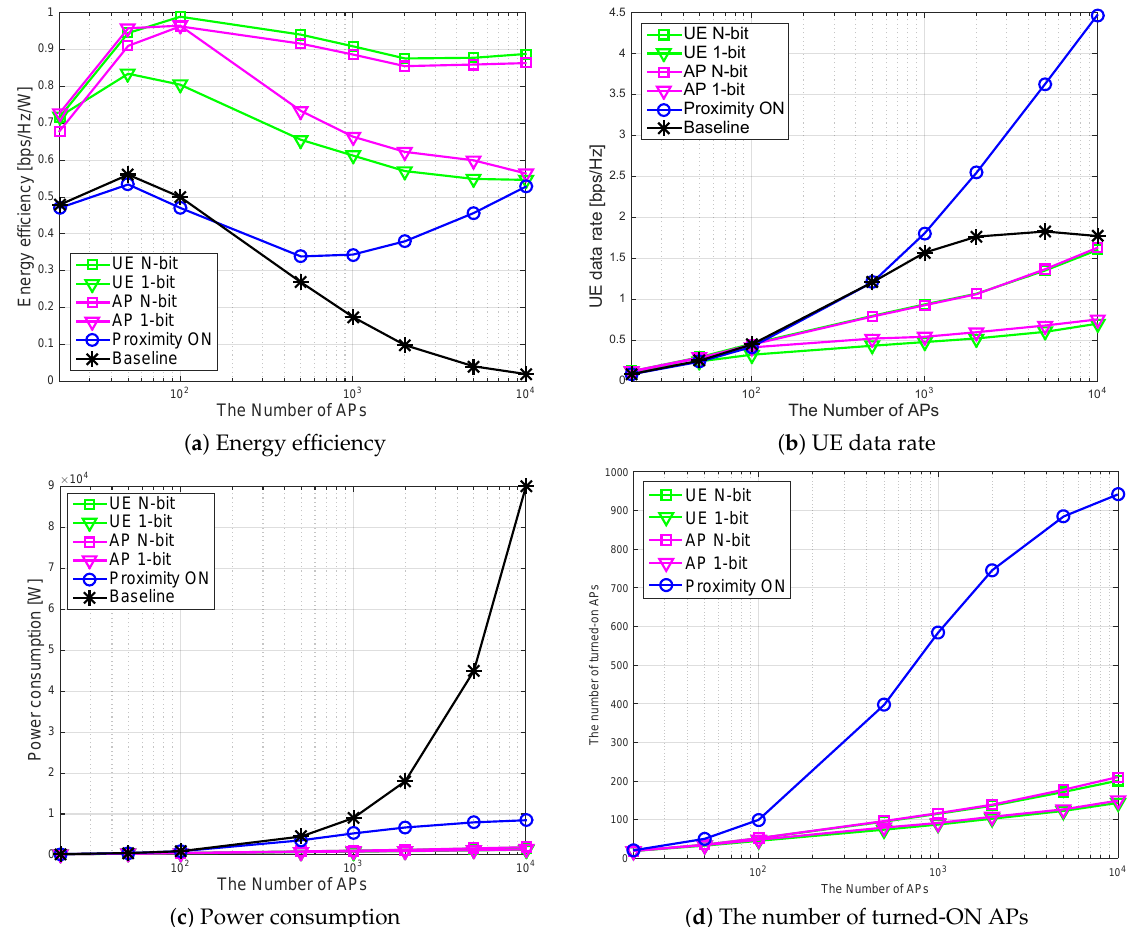
Figure 9. Green small cell operation under ultra-dense